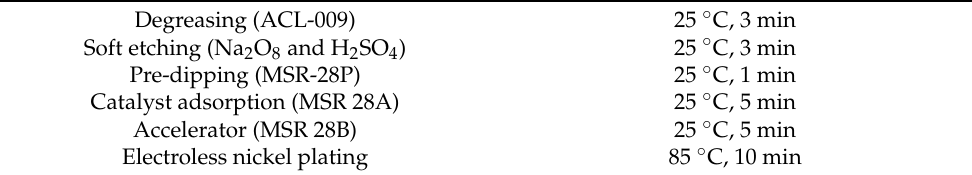
Table 1. Electroless nickel plating with the pretreatment